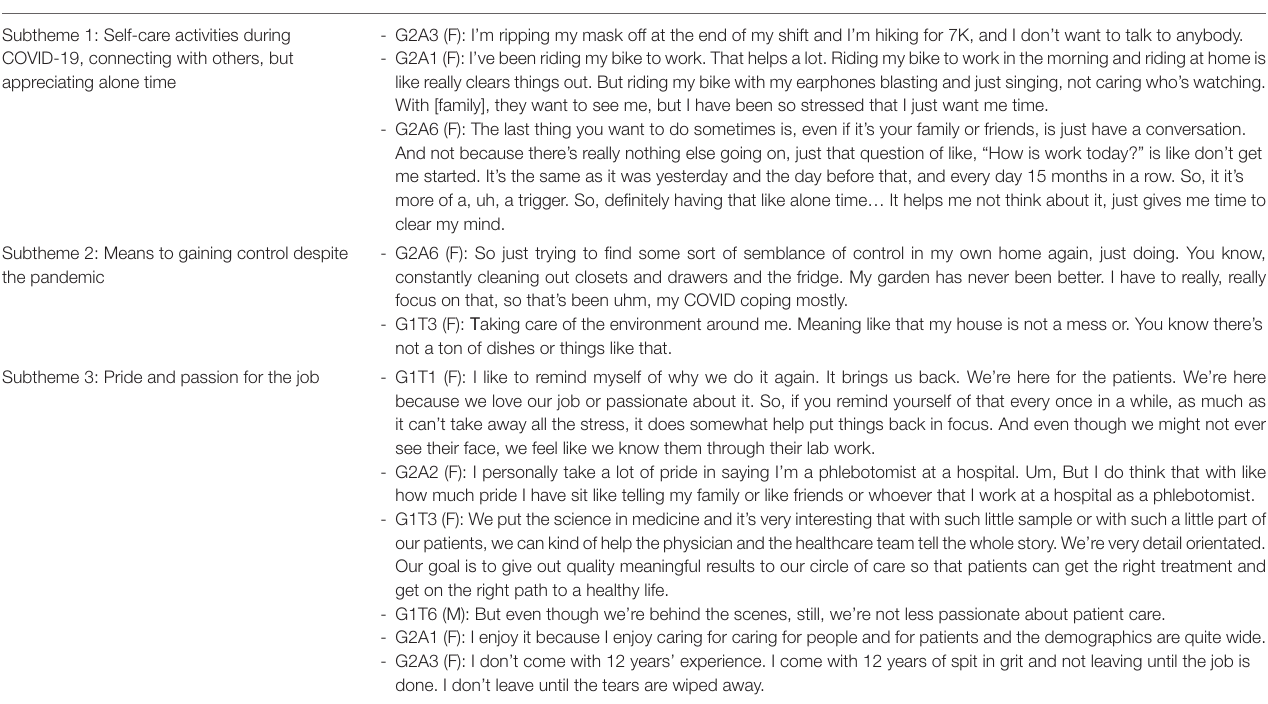
TABLE 6 | Theme 4: A resilient and passionate group. Subtheme 1: Self-care activities during COVID-19, connecting with others, but appreciating alone